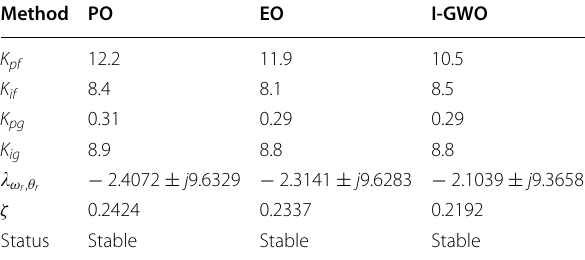
Table 4 Optimal values for PI